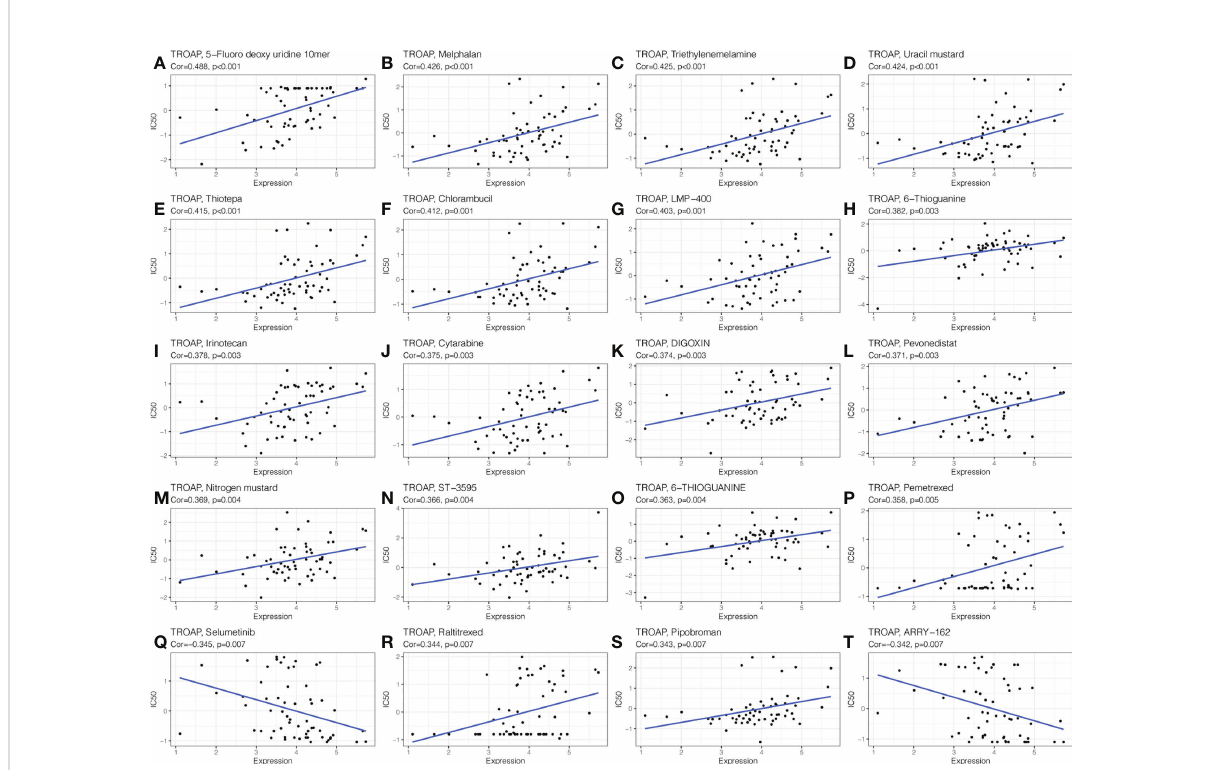
FIGURE 13 The drug sensitivity analysis of TROAP expressed level and various chemical drugs in pan-cancer. The TROAP expression was positively associated with drug sensitivity of (A) 5 − Fluoro deoxy uridine 10mer, (B) Melphalan, (C) Triethylenemelamine, (D) Uracil mustard, (E) Thiotepa, (F) Chlorambucil, (G) LMP − 400, (H) 6 − Thioguanine, (I) Irinotecan, (J) Cytarabine, (K) DIGOXIN, (L) Pevonedistat, (M) Nitrogen mustard, (N) ST − 3595, (O) 6 − THIOGUANINE, (P) Pemetrexed, (R) Raltitrexed, and (S) Pipobroman. The TROAP expression was negatively associated with drug sensitivity of (Q) Selumetinib and (T) ARRY − 162. The X -axis represents the TROAP expression level and Y -axis represents the value of